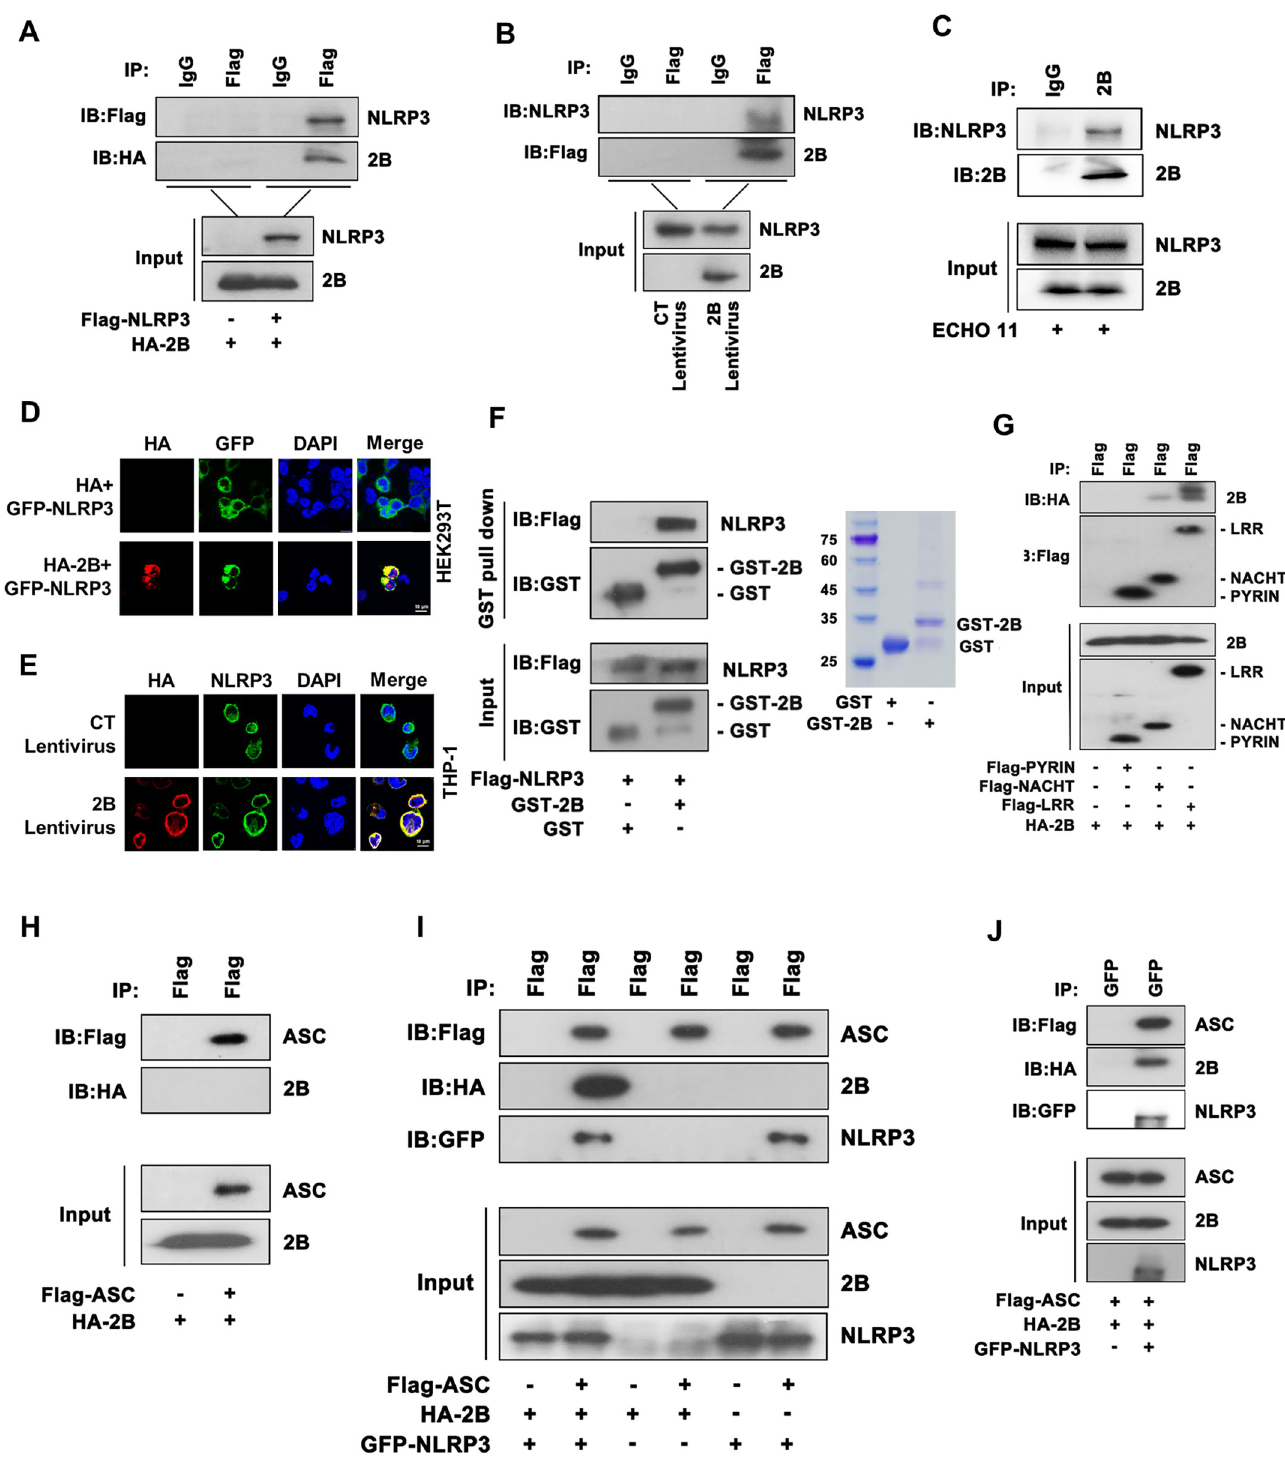
Fig 5. ECHO 11 2B interacts with NLRP3 to facilitate inflammasome assembly. ( A ) 293T cells were co-transfected with plasmids encoding HA-2B and Flag- NLRP3, subjected to Co-IP using anti-Flag antibody or anti-IgG antibody, and analyzed by Western blotting with anti-Flag and anti-HA antibodies. ( B ) THP-1 macrophages stably expressing Flag-2B were subjected to Co-IP using anti-Flag or anti-IgG antibodies, and analyzed by Western blotting with anti-Flag and anti- NLRP3 antibodies. ( C ) THP-1 macrophages were infected with ECHO 11 at an MOI of 0.5 for 24 h, subjected to Co-IP using anti-2B or IgG antibodies, and analyzed by Western blotting with anti-2B and anti-NLRP3 antibodies. ( D-E ) The subcellular localizations of HA-2B (red), GFP-NLRP3 (green), and nucleus